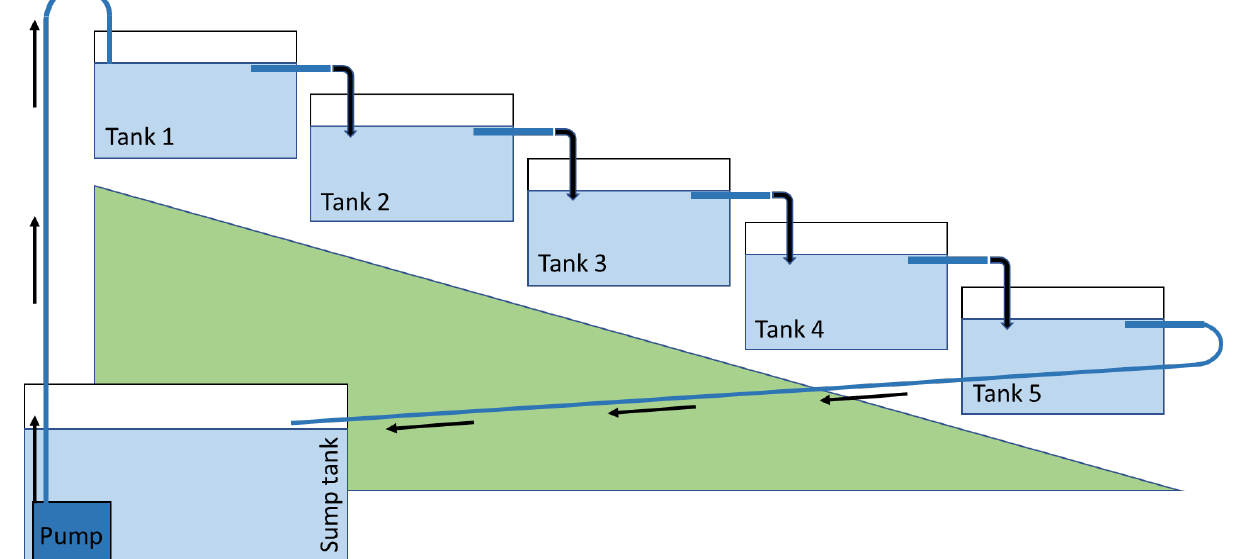
Figure 5. Schematic of the semi-outdoor, 35 L, recirculatory cultivation system.